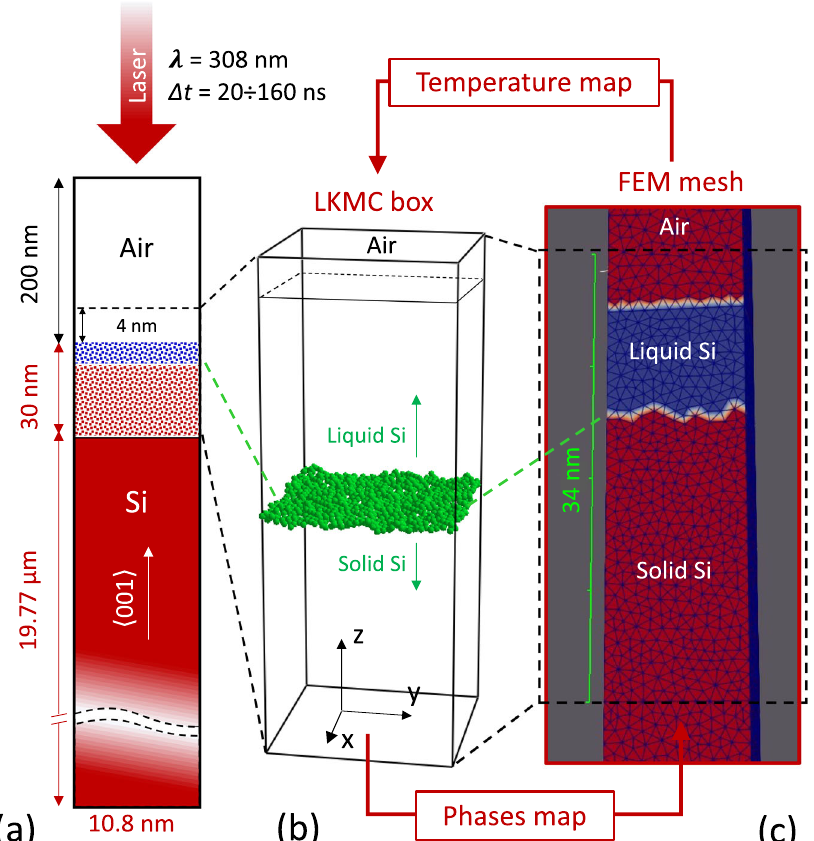
Fig. 2 Schematics of a multiscale FEM-KMC ultrafast melting simulation for a Si(001) surface. a Sketch of an input CAD geometry, with the KMC subregion indicated by the dotted area, which is blue for liquid and red for solid Si. b KMC system at a generic time during melting, with the solid undercoordinated Si atoms indicated in green. c Region of the FEM mesh corresponding to the KMC one, with liquid Si in blue and solid/air in